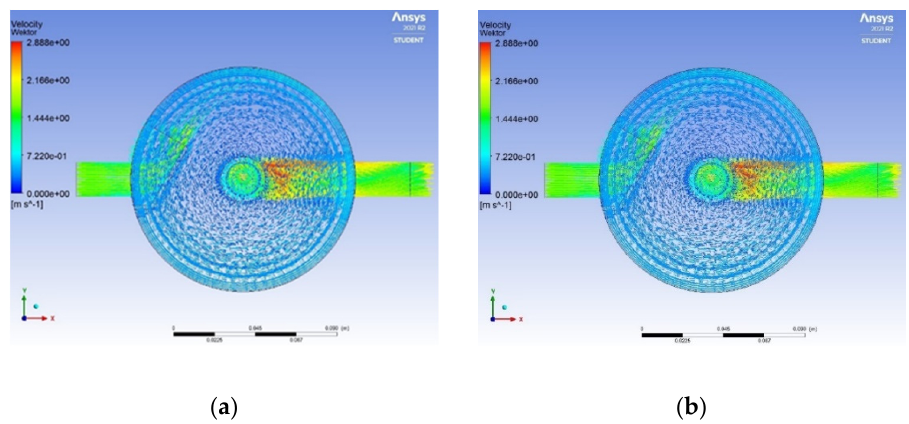
Figure 6. Velocity vector fields for the OW model in the case of velocity. ( a ) v 1 ; ( b ) v 5 .